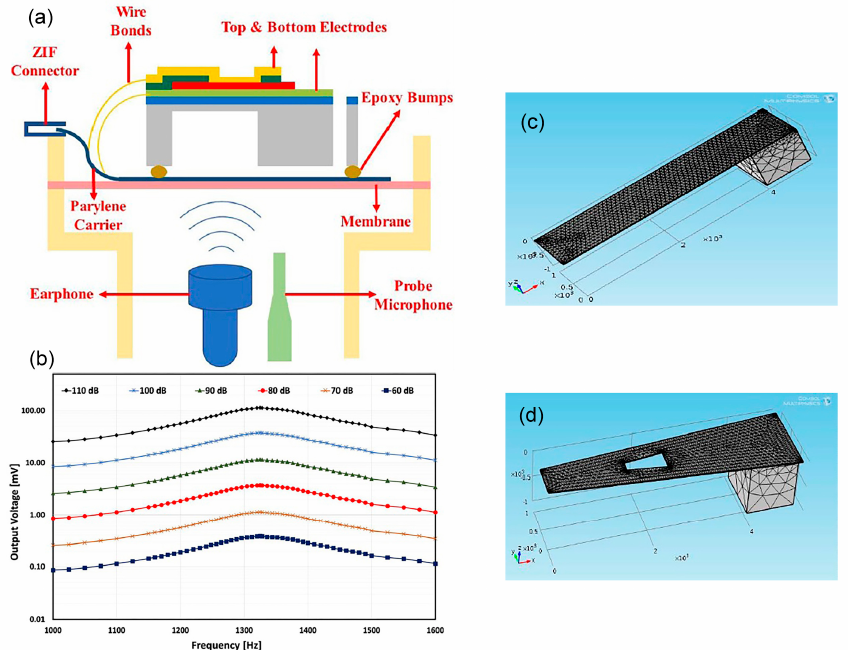
Figure 6. ( a ) The acoustic characterisation setup and ( b ) the measured acoustic results of a PZT energy harvester at sound pressure level from 60 dB to 100 dB SPL. Reprinted from [50], Copyright (2018), with permission from Elsevier. The meshed ( c ) rectangular and ( d ) tapered perforated ZnO cantilever structure with proof mass. The tapered perforated structure has the same area as the rectangular cantilever and the narrower side is fixed while the broader side is free to vibrate. © 2017 IEEE. Reprinted, with permission, from [51].